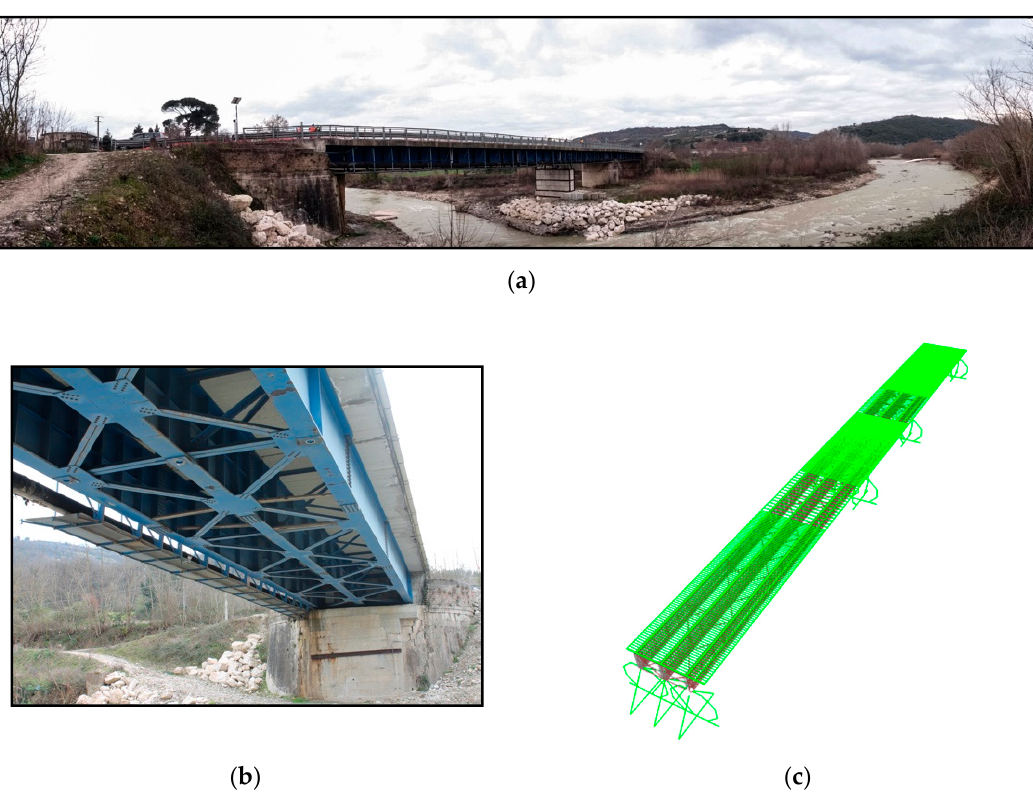
Figure 3. Ufita bridge overview ( a ); view of the composite deck ( b ); FE model ( c ).